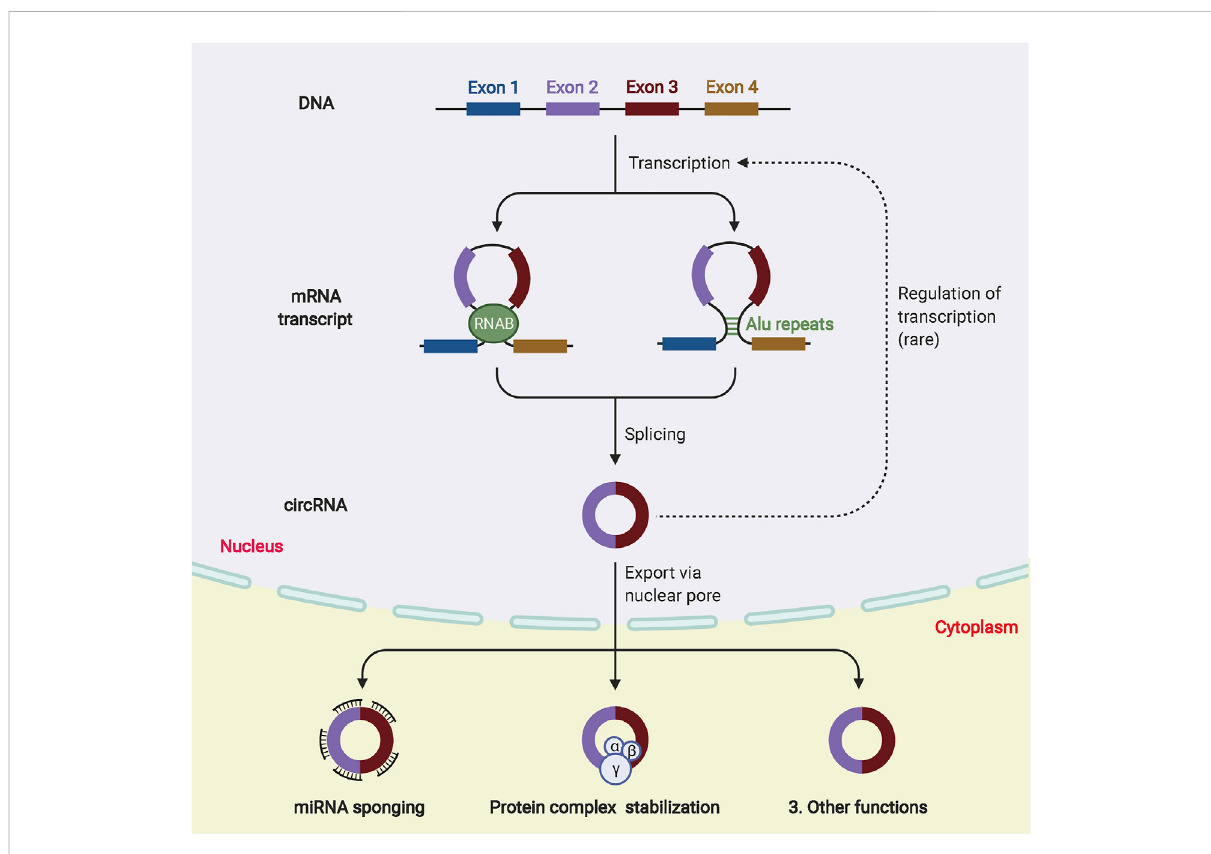
FIGURE 4 The biogenesis and biological function of circRNAs. Different circRNAs can be generated from pre-mRNA by back-splicing. According to the synthesis mechanism, circRNA can be divided into ecircRNA, ciRNA and eiciRNA. In the nucleus, circRNAs can participate in transcriptional regulation. In the cytoplasm, circRNAs are involved in many biological processes, such as miRNA sponge formation and binding to